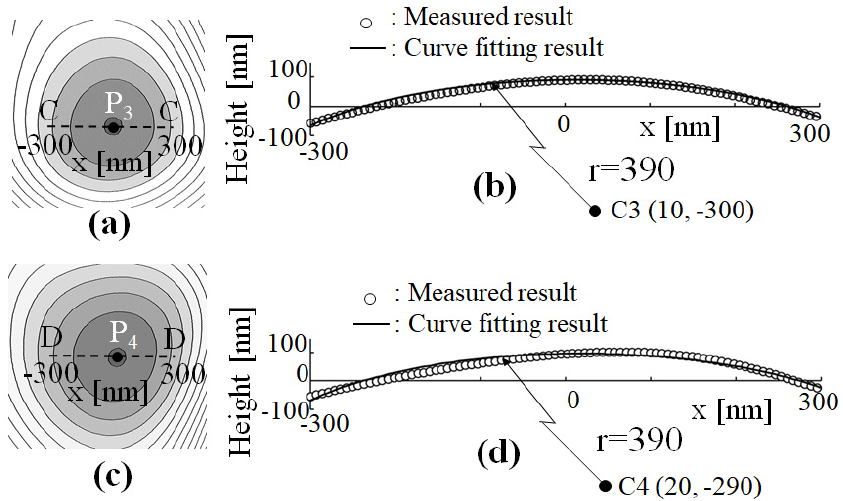
Figure 10. Measured 3D shape of 700 nm sphere at the same position: ( a ) Contour of measured 3D shape without aperture in Area-B; ( b ) Measured 3D shape without aperture in Area-B; ( c ) Contour of measured 3D shape with aperture in Area-C; ( d ) Measured 3D shape with aperture in